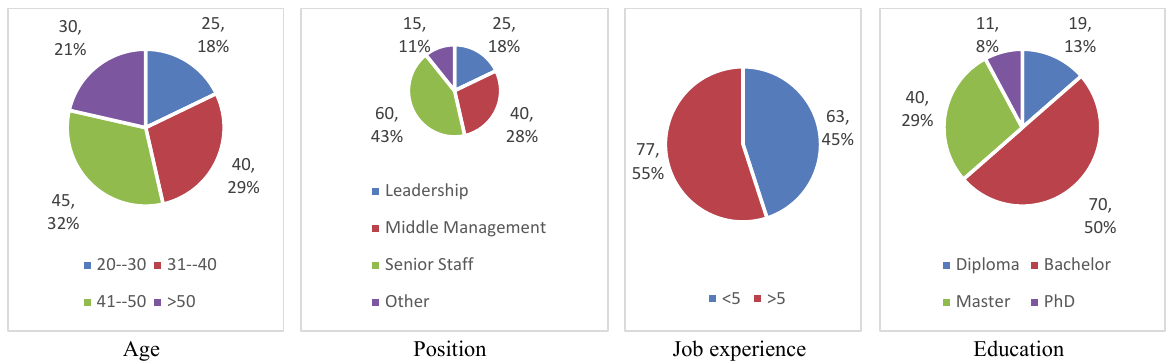
Fig. 1. Personal characteristics of the